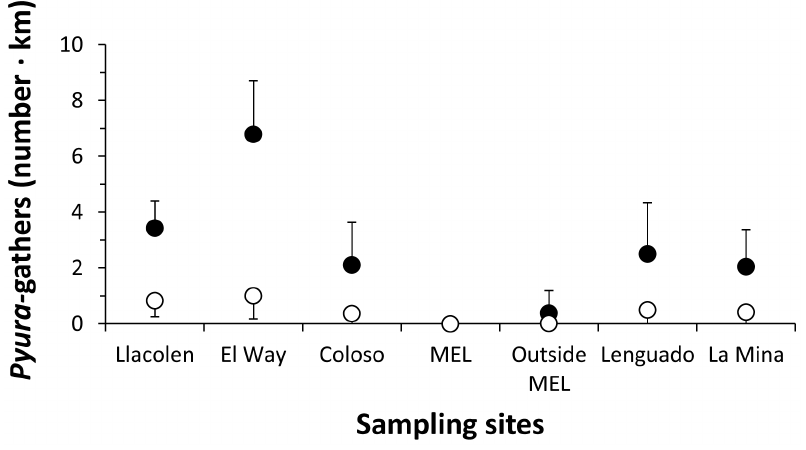
Figure 6. Mean number ( ± SD) of Pyura -gathers per km recorded over 13 months (1993–1994), in January and February (black circles) and the rest of the year (white circles) (taken and modified from 47).